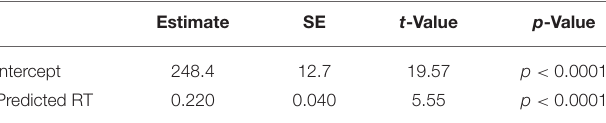
TABLE 3 | The linear model with Intercept and Predictive RT.